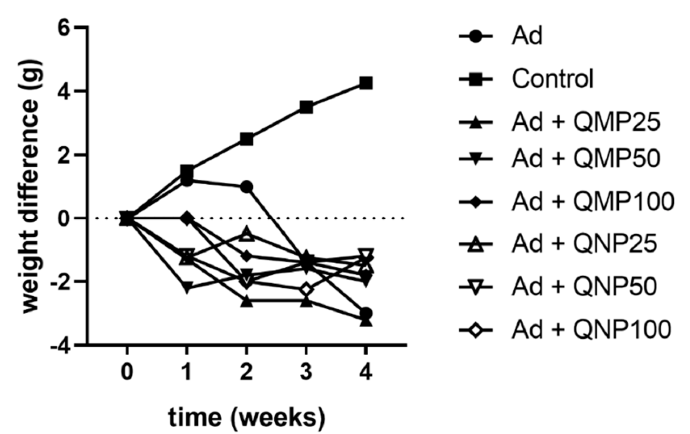
Figure 2. Effect of quercetin macroparticles and nanoparticles on the weight of mice during the 28 day treatment. Bodyweight of mice was registered weekly until sacrifice. QMPs and QNPs treatments prevented weight loss caused by adenine intoxication.